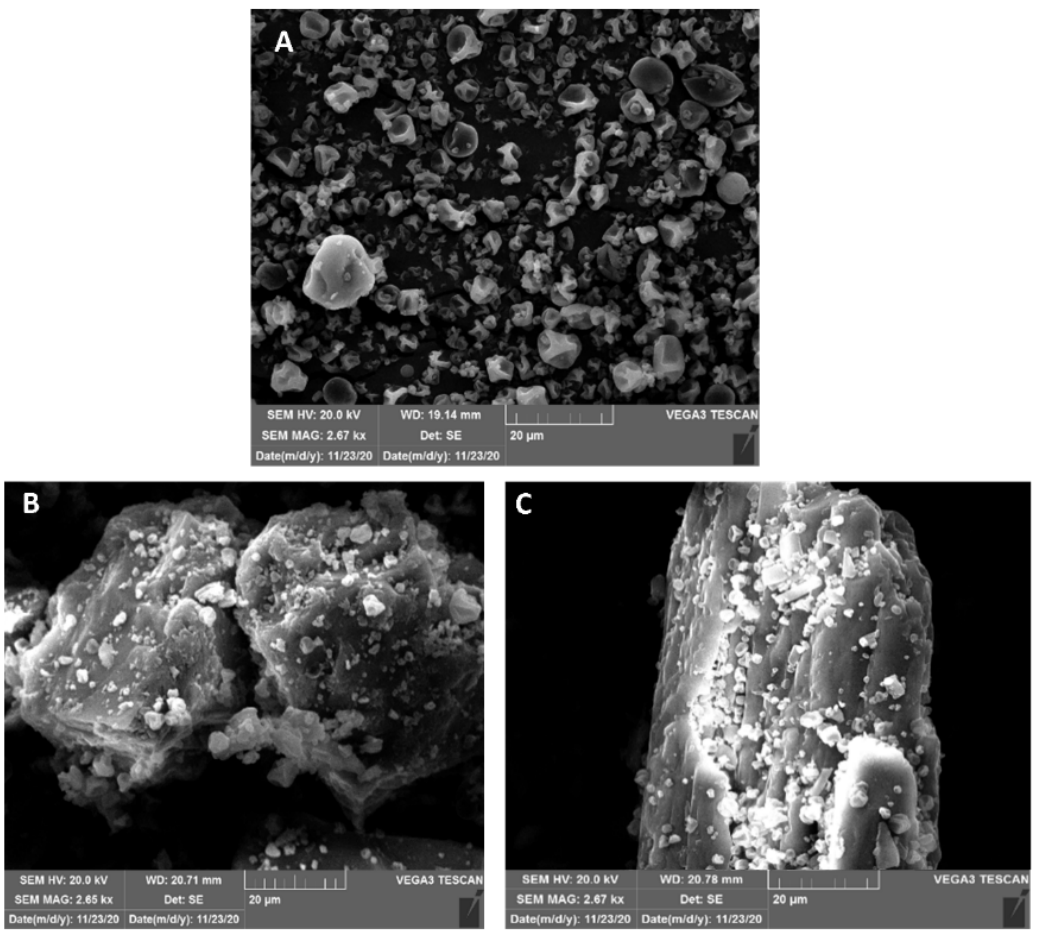
Figure 5. SEM micrographs of DSP-MS ( A ), DSP-MS/lactose blend ( B ) and DSP-MS/mannitol blend ( C ) with DSP-MS to inert carrier ratio 1:9, w/w.